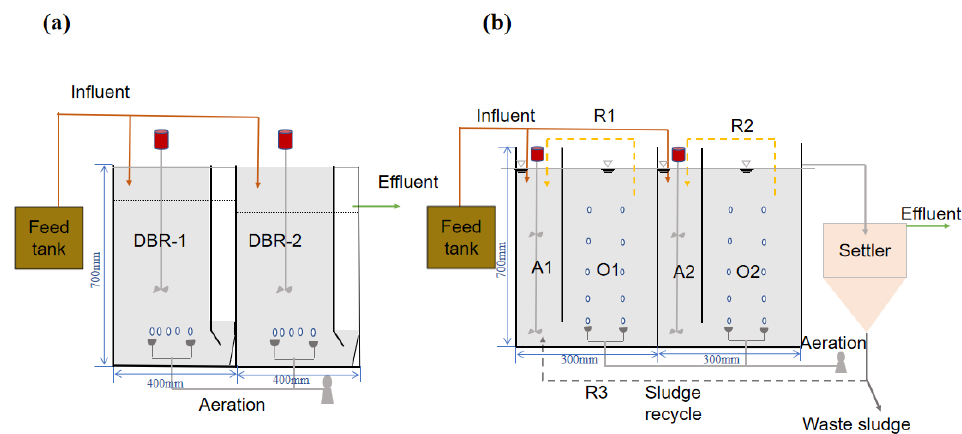
Figure 1. Schematic diagram of the DBR system ( a ) and the A/O/A/O system ( b